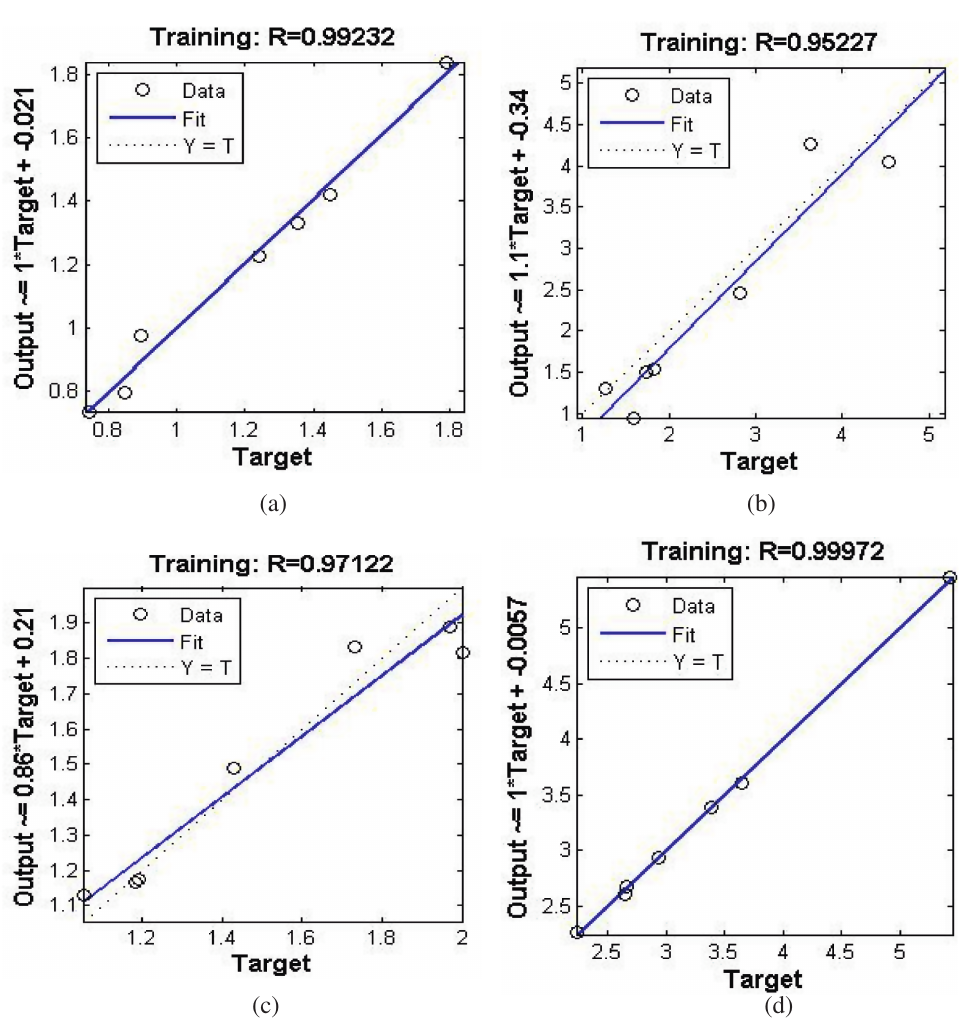
Figure 6: The best fitness value estimated by BPNN model (a) DOP for 1 st trials (b) BW for 1 st trials (c) DOP for 2 nd trials and (d) BW for 2 nd